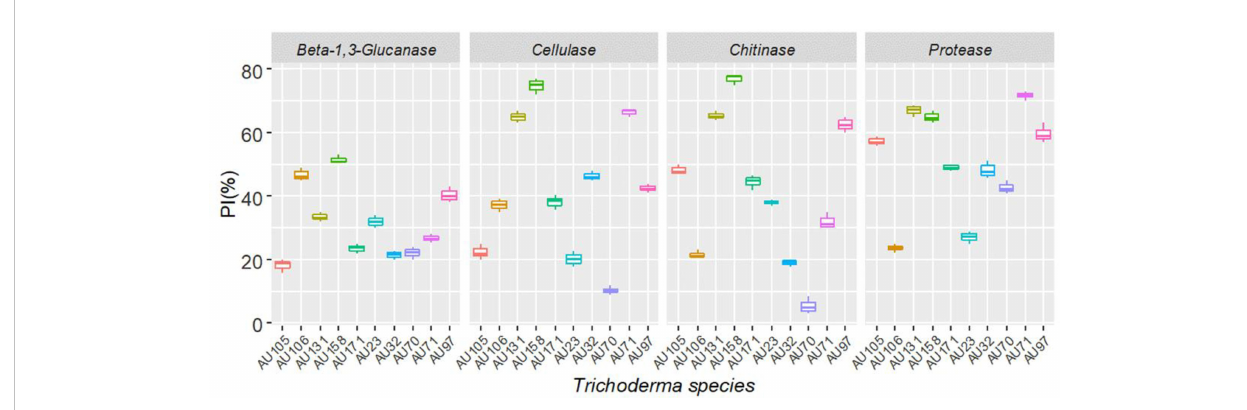
FIGURE 3 Boxplots of the hydrolytic enzyme activity of 10 Trichoderma isolates against F. xylarioides. Trichoderma isolates: T. viride AU23, T. longibrachiatum AU32, T. koningiopsis AU70, T. asperelloides AU71, T. asperellum AU97, T. harzianum AU105, T. aethiopicum AU106, T. asperellum AU131, T. longibrachiatum AU158 and T. asperellum AU171. The boundaries of the boxplots indicate the 25 th and 75 th percentiles, and the solid line within the boxes indicates the median value. PI, Percentage of